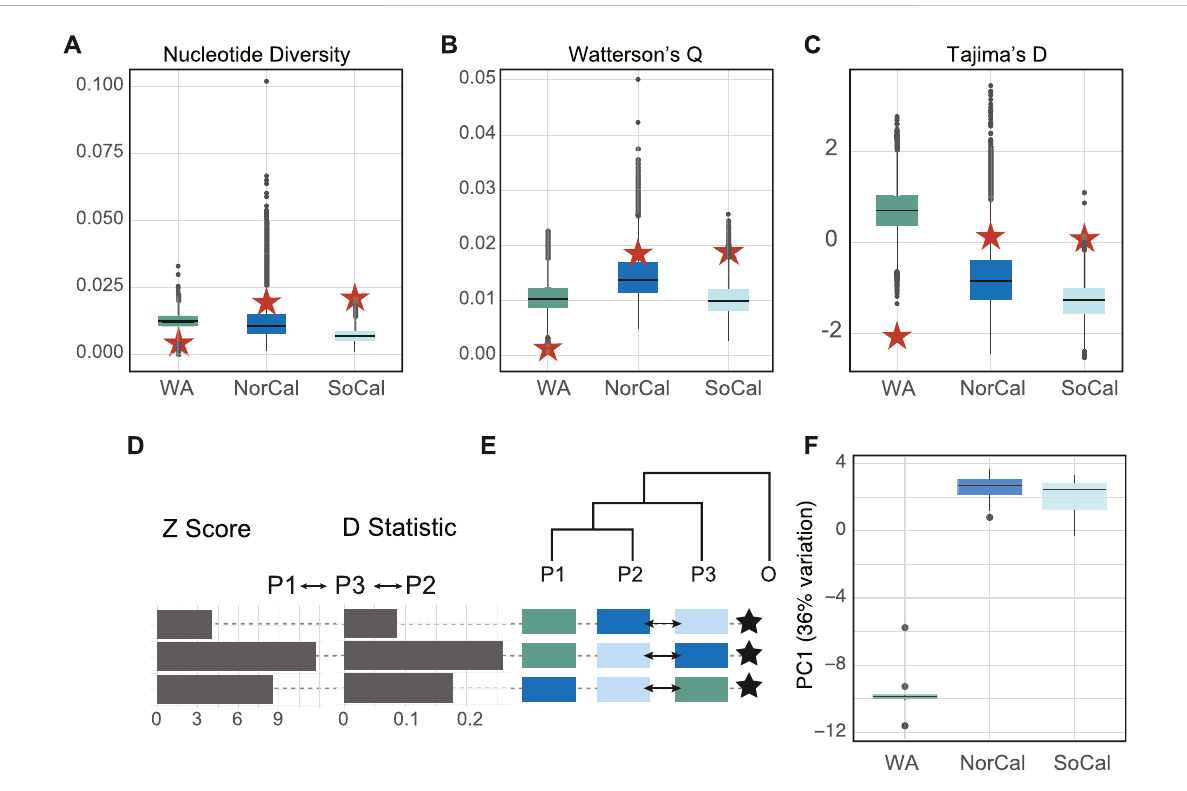
FIGURE 3 Per-siteestimatesof (A) nucleotidediversity( π ), (B) Waterson ’ s θ , (C) Tajima ’ sDteststatisticsfornuclear(boxplots)andmitochondrialgenomic data (red stars), (D) Z-scores and D-statistics for ABBA-BABA comparisons between populations with M. leidyi as an outgroup for nuclear genomes, (E) Cartoon tree represents hypotheses to test whether population 3 (P3) shared more ancestral versus derived alleles with population 1 (P1) relative to population 2 (P2). Positive-shifted histograms (excess of ABBA) represent signi fi cant gene fl ow between P2 and P3, negative-shifted histograms (excess of BABA) for signi fi cant gene fl ow between P1 and P3. Arrows on tree cartoons indicate gene fl ow between populations. Stars indicatesigni fi cantz-scores > threestandarddeviationsfromzero. (F) Boxplotsofthe fi rstPCAaxisofnucleargenomesforeachpopulationmapped to M. leidyi for 14,396 polymorphic sites that represented 36% of variation. Populations colored by locality: Friday Harbor (WA, green), the Monterey Bay area (NorCal, blue) and San Luis Obispo – Channel Islands, CA (SoCal, light